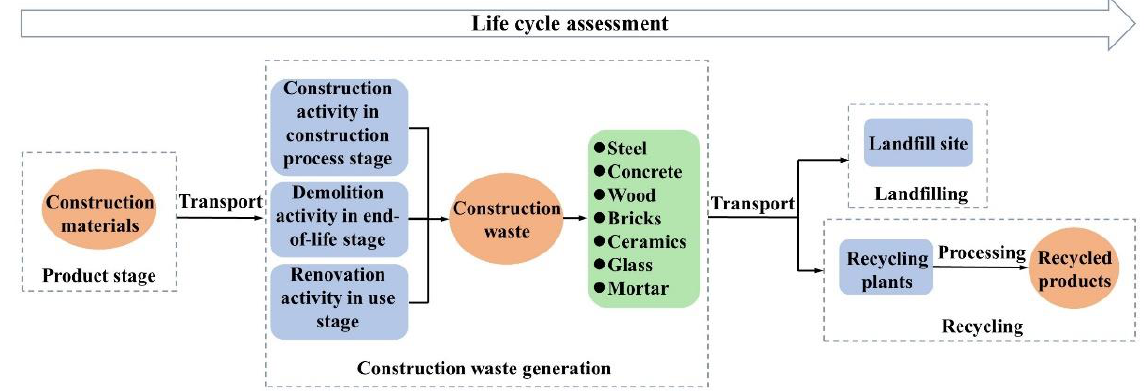
Figure 3. The LCA framework of construction waste.